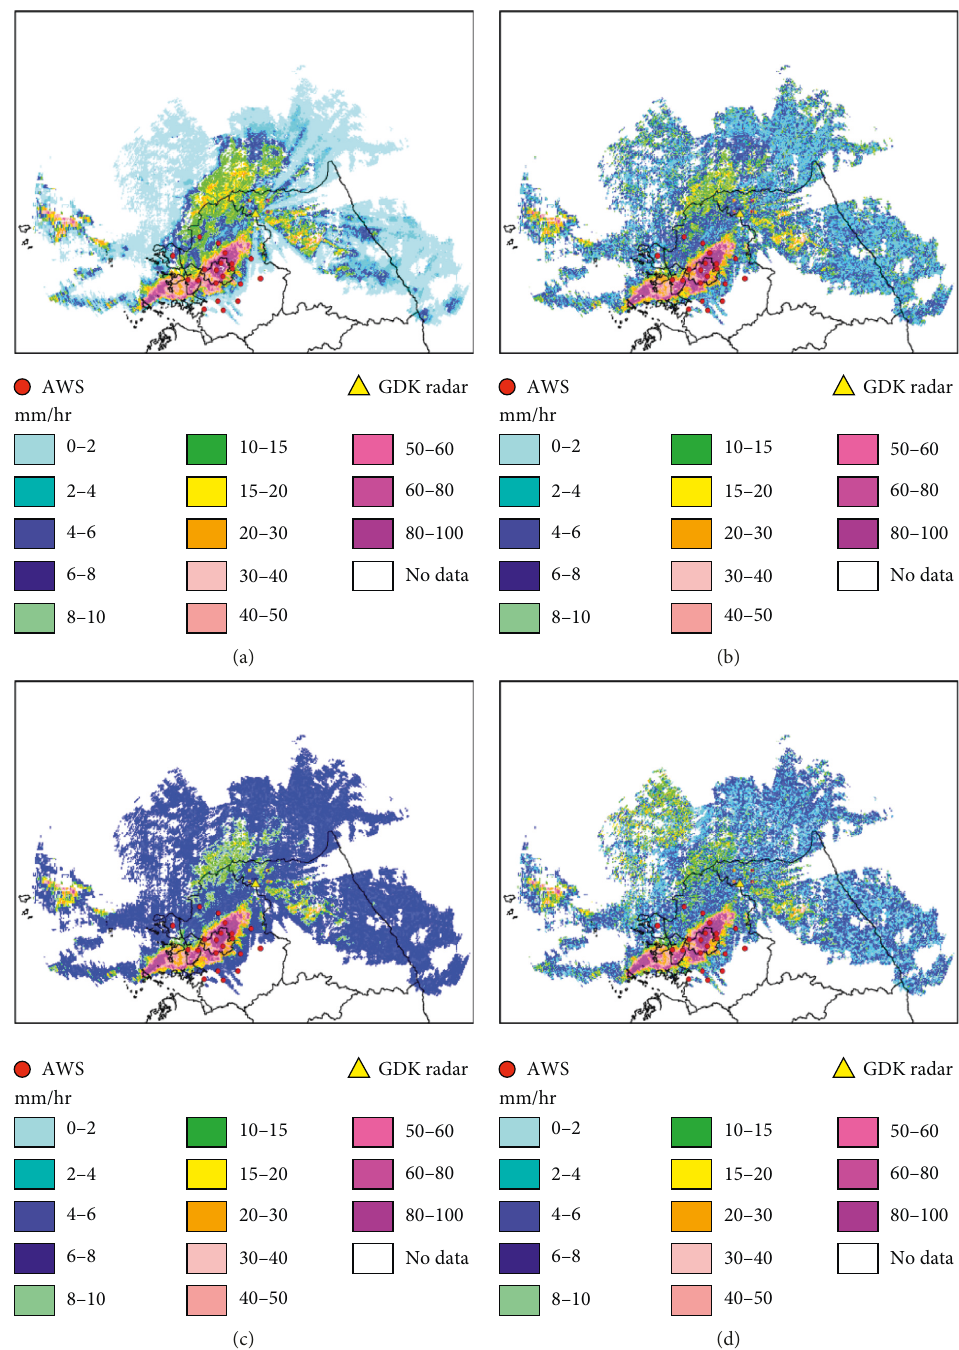
Figure 7: Radar rainfall rate fields for four selected quantitative precipitation estimation models (ZR2–L1, RF3, GBM3, and ELM5) for event #1 (August 28, 2018; 20:10). (a) ZR. (b) RF. (c) GB. (d)